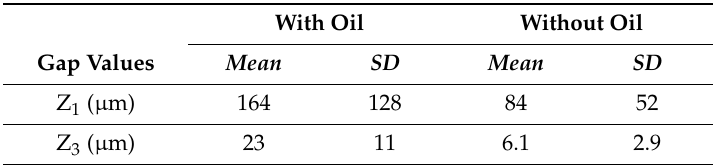
Table 2. Gaps measured at room temperature after annealing by tomographic observations at locations Z 1 and Z 3 on 18 specimens with and 18 specimens without oil. Mean and standard deviation (SD) are shown. With Oil Without Oil Gap Values Mean SD Mean SD Z 1 ( µ m) 164 128